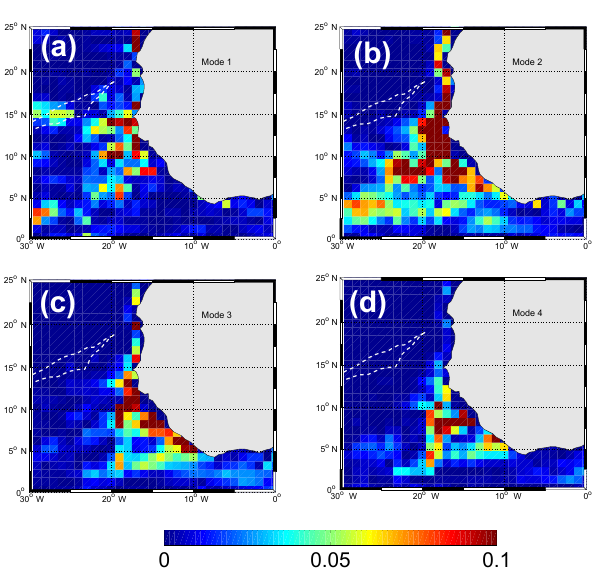
Figure 15. Vertically integrated kinetic energy (m 3 s − 2 ) for the semiannual meridional velocity decomposed onto baroclinic modes. Only the first four modes are shown. Time averaging is performed over the semiannual cycle. The two white dashed lines represent the location where zero PV gradients are found in Fig.